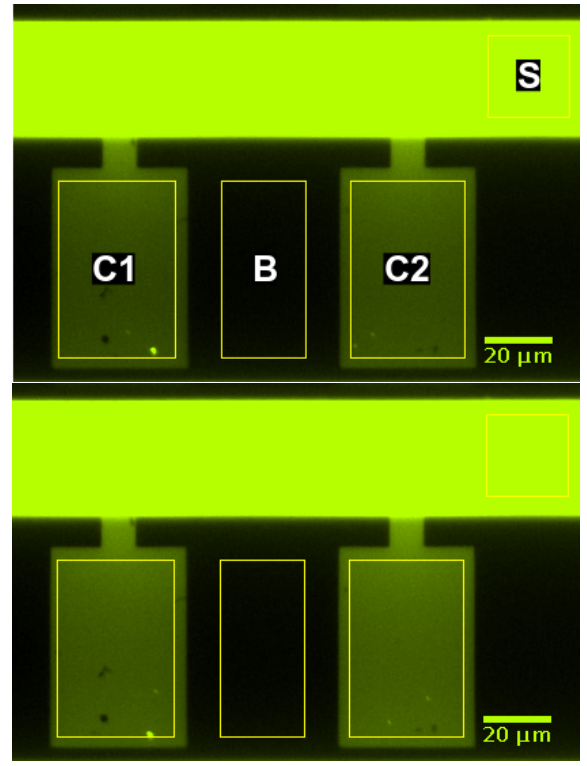
Figure 8. Fluorescence signal in supply channel (S), growth chambers (C1, C2), and background region (B) at t = 42s ( top ) and t = 80s ( bottom